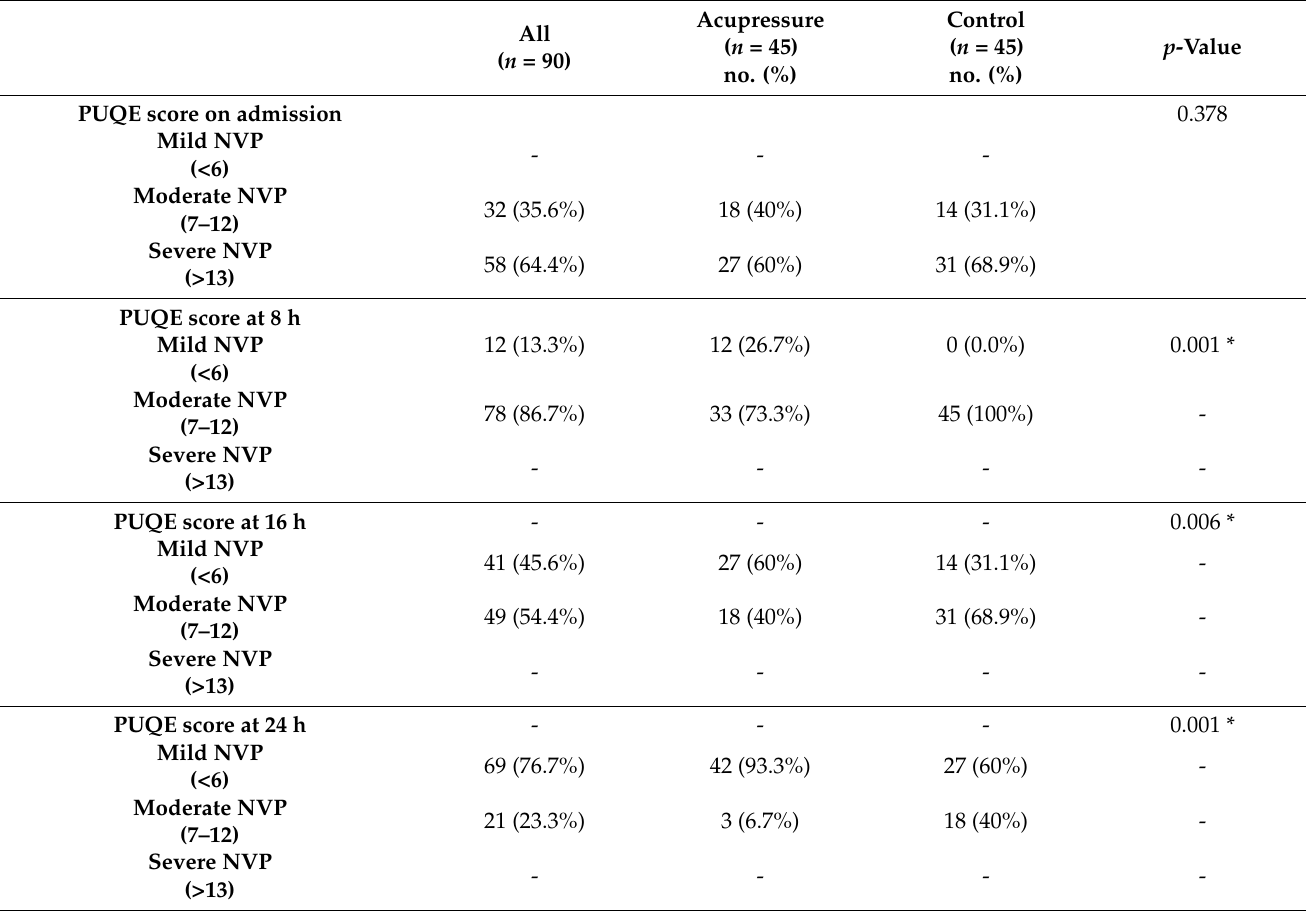
Table 2. Modified Pregnancy Unique Quantification of Emesis and Nausea (PUQE) scores in intention- to-treat population. * indicates statistically significant; p < 0.05.